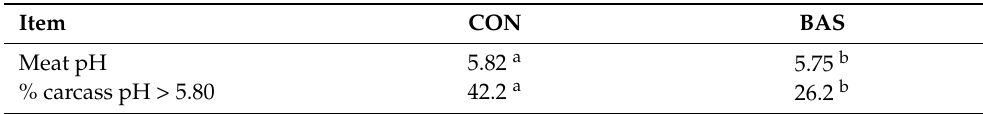
Table 6. Effects of bovine appeasing substance (BAS) administration meat pH and proportion of carcasses with a pH greater than 5.80 in finishing beef bulls 1,2